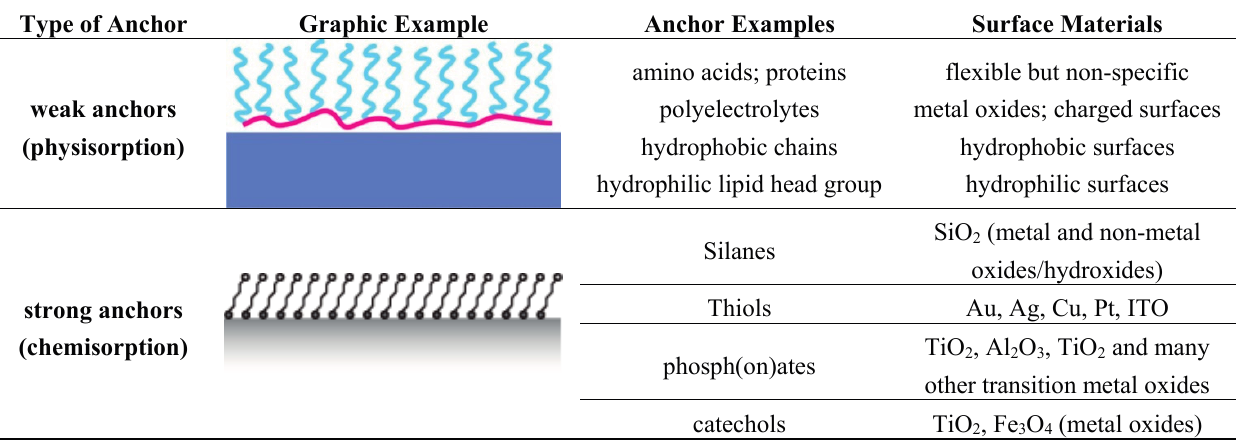
Table 1. Compatibility of weak and strong anchors to different surface